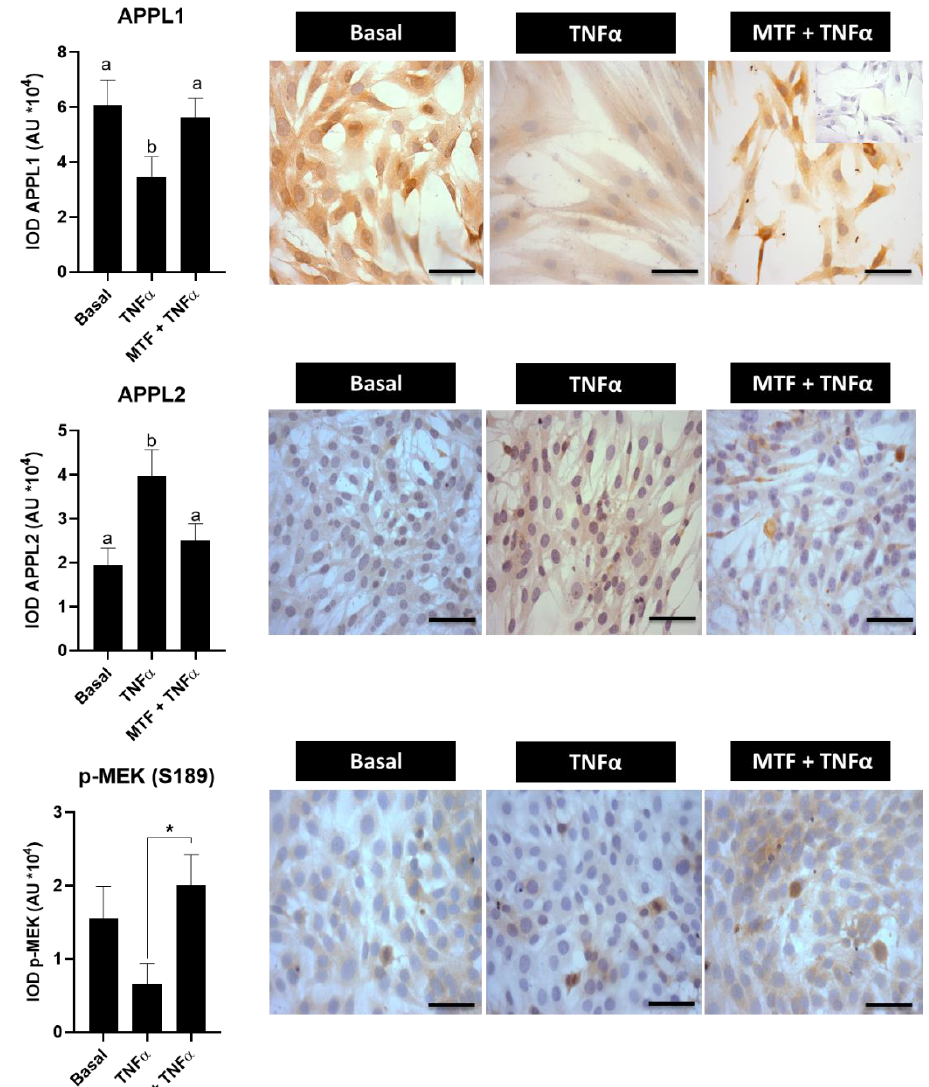
Figure 5. Effect of metformin on the expression of adiponectin signaling-associated molecules in human endometrial cells exposed to TNF α treatment. APPL1, APPL2 and phosphorylated MEK (S189) protein levels in human endometrial cells treated for 24 h with TNF α (100 ng/mL) with or without metformin (MTF, 20 nM) as determined by immunocytochemistry (ICC). Photomicrographs show the tissue locations of APPL1, APPL2 and p-MEK (S189) by immune-positive brown color staining in each sample. The graphs show the semi-quantification obtained by the IOD tool. Inner box: negative control; bar = 50 μm; images at 400× (in (A): image of 200× in inner box). Three independent experiments were performed for each treatment ( n = 3; in duplicate). In the graphs, a ≠ b indicates a statistically significant difference with a * p -value < 0.05. Regarding the p-MEK graph: p -value < 0.05 TNFα vs. TNFα+MTF; non-parametric test and Dunn’s post hoc est. Data are shown as mean AU (arbitrary units *10 4 ) ± SEM.